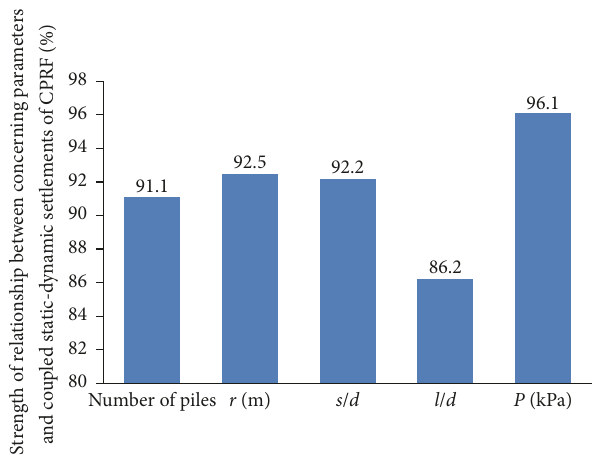
Figure 25: Strength of relationship between input parameters and CPRF settlements in the coupled static-dynamic